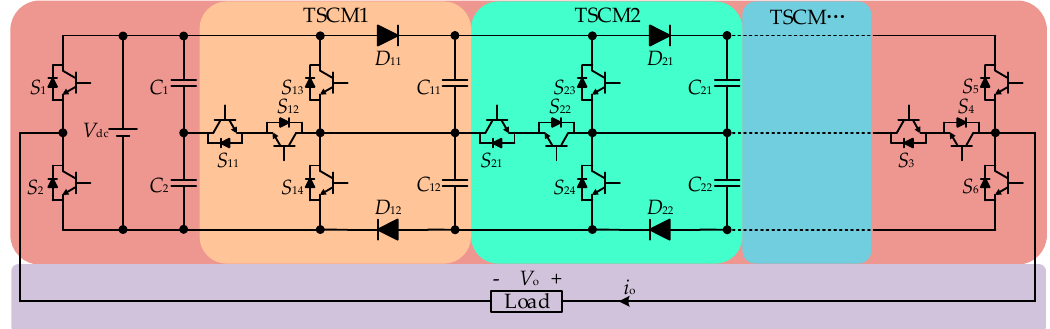
Figure 10. Cascaded topology of multi-TSCM.